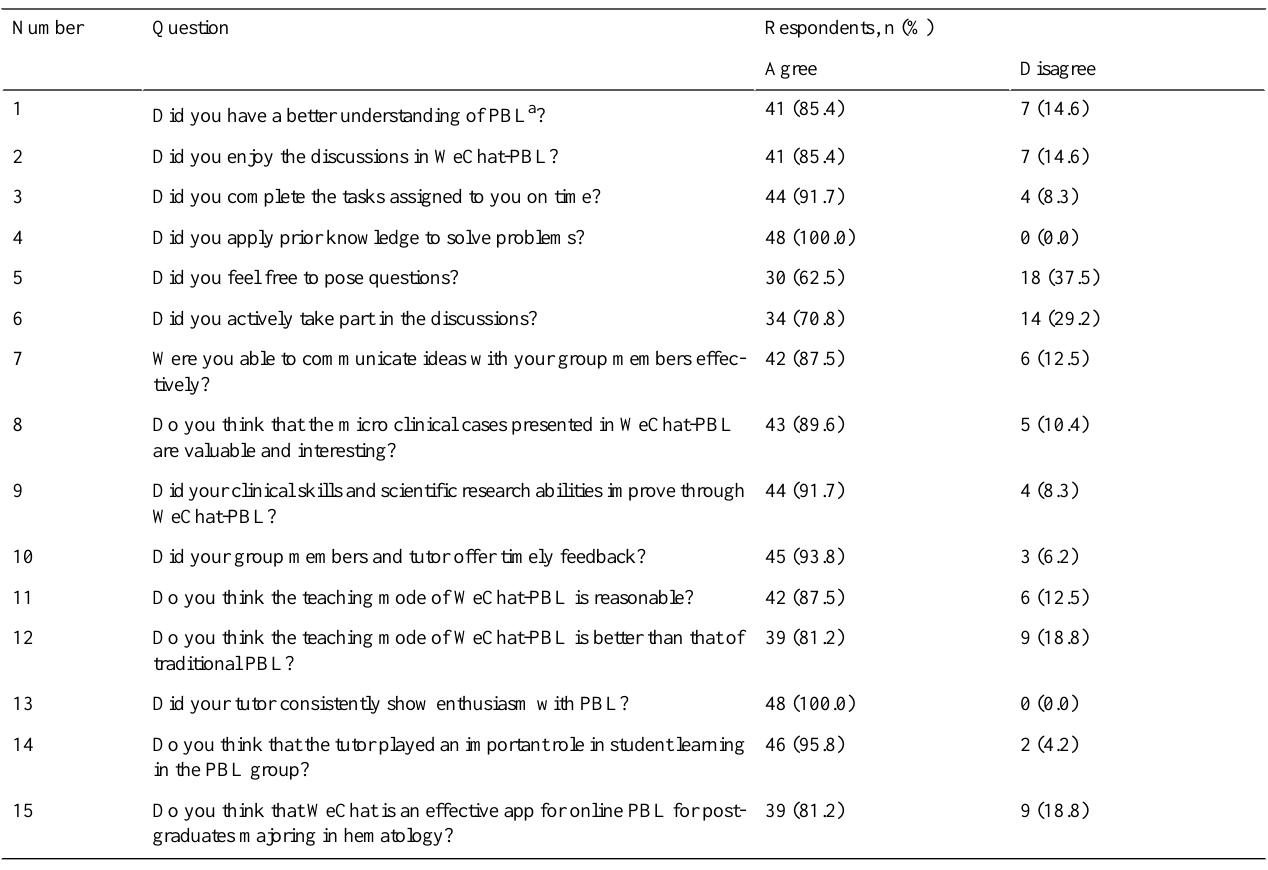
Table 1. Results of the overall evaluation of the WeChat-PBL teaching